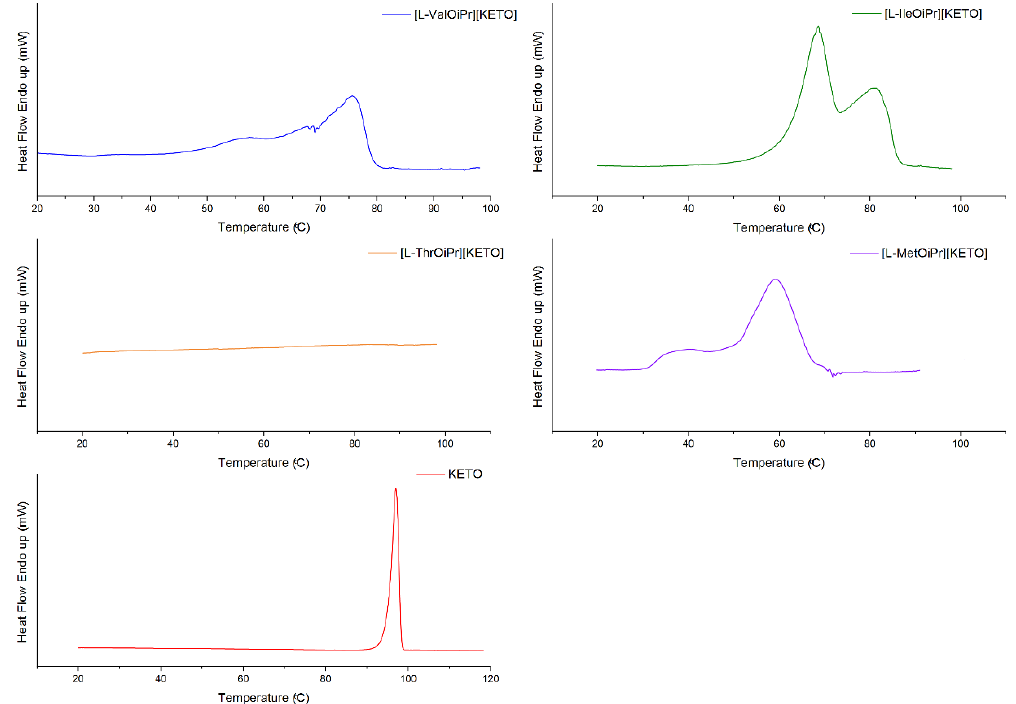
Figure 3. The DSC curves of first heating cycle of ketoprofen and ketoprofen salts: [L − ValOiPr][KETO] (blue), [L − IleOiPr][KETO] (green), [L − ThrOiPr][KETO] (orange), [L − MetOiPr][KETO] (purple), KETO (red).